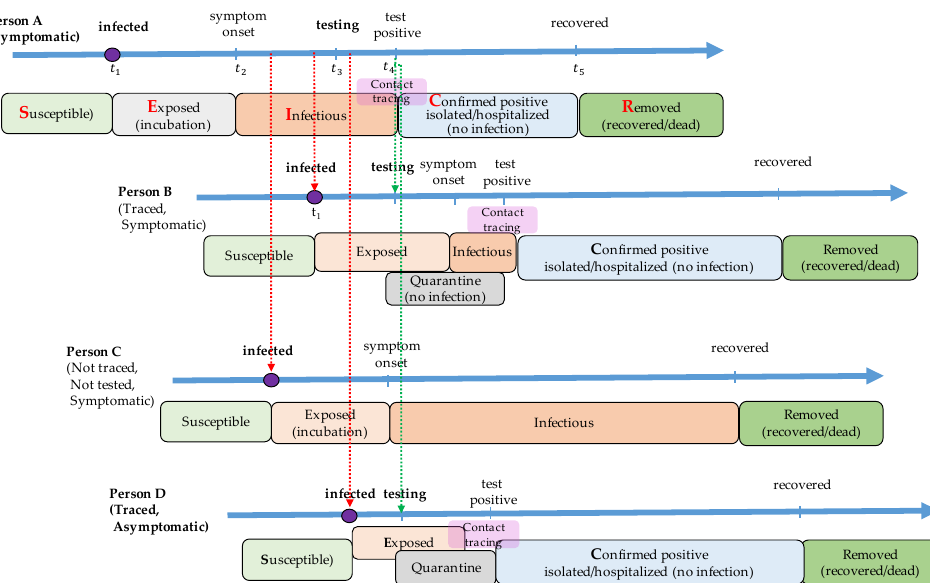
Figure 2. An example of testing and contact tracing process with a symptomatic individual. A susceptible individual (Person A) is exposed to the virus at time 𝑡 1 . After an incubation time, he or she shows symptoms at 𝑡 2 . A screening test is carried out at 𝑡 3 , and a test result is confirmed at 𝑡 4 . When the test result is positive, he or she is isolated from others, and the contact tracing process is initiated. Persons B and D are traced from the contact tracing process, and they are tested and quarantined for 14 days no matter what the test results are. Even though Person B and Person D get infected, they may not transmit the disease anymore once the contact is traced. On the other hand, person C, who has not been traced, does not know that he or she is infected and possibly transmits the virus to others. When Person B (or Person D) is confirmed positive through the screening test, a new contact tracing process is initiated.